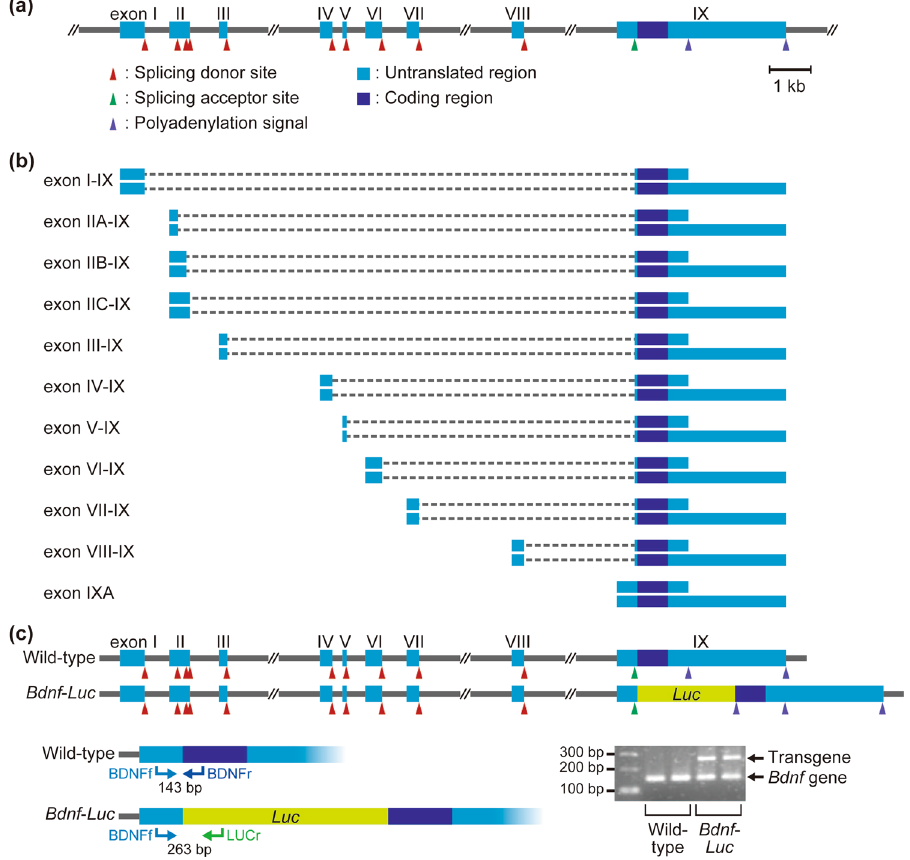
Figure 1. Generation of Bdnf - Luc Tg mice. ( a , b ) Structure of mouse Bdnf gene ( a ) and its multiple transcripts ( b ). Scale bar = 1 kb. ( c ) Schematic representation of wild-type Bdnf gene and luciferase-inserted transgene ( Bdnf - Luc ) in BAC and genotyping PCR result. Using three kinds of primers, BDNFf, BDNFr, and LUCr, genomic DNA extracted from mouse tail were amplified by PCR, and the PCR products were separated on 2% agarose gel. PCR products of Bdnf gene (143 bp) and Bdnf - Luc transgene (263 bp) are shown by arrows. A full- length gel is presented in Supplementary Figure